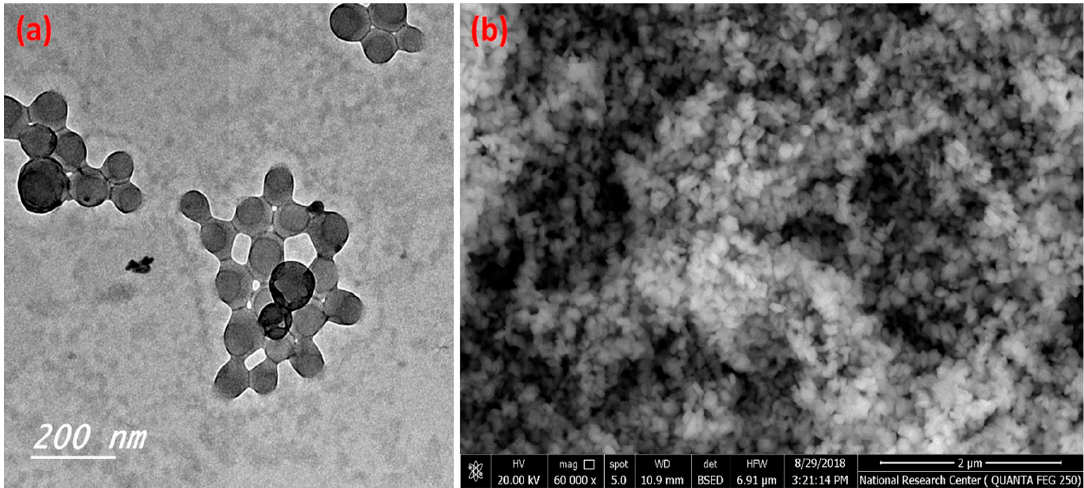
Figure 1. TEM ( a ) and SEM ( b ) of the prepared C-NPs.